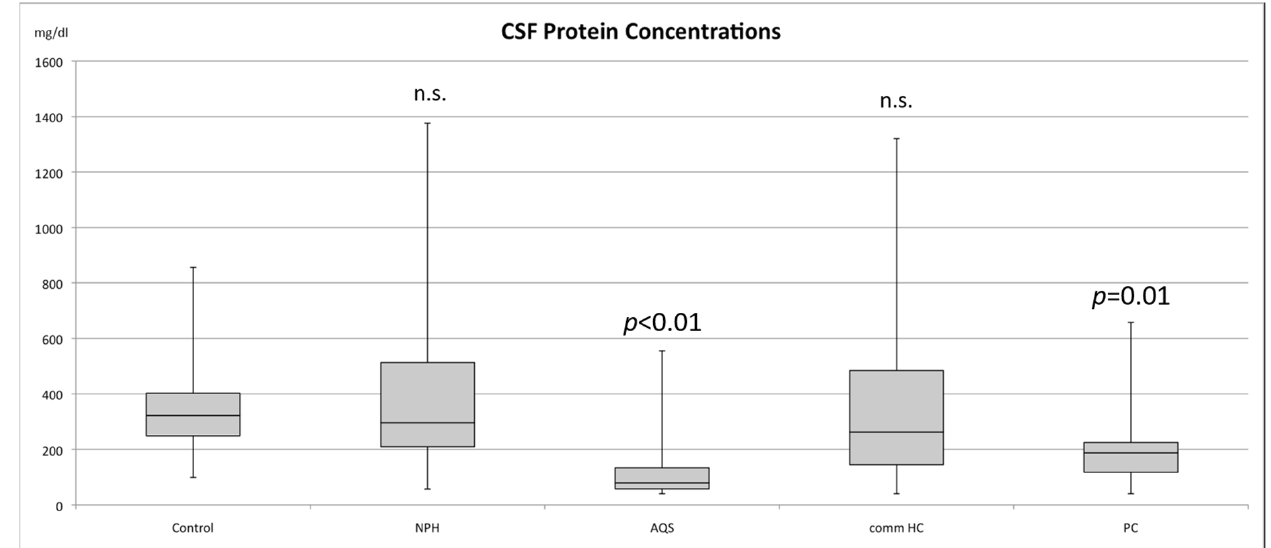
Figure 1. Boxplot for the total CSF protein concentrations for the individual subgroups of hydrocephalic patients, pseudotumor cerebri patients and the control group. p -values compared with controls are shown. p -values above 0.05 were considered non-signi fi cant (n.s.).